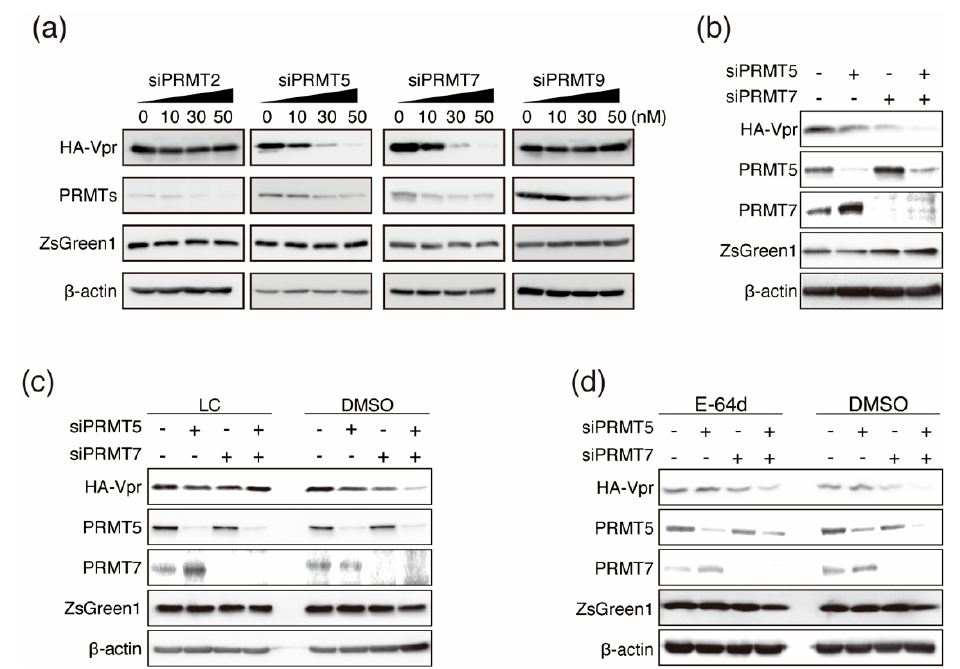
Figure 3. Downregulation of HA-Vpr after siRNA knockdown of PRMTs and rescue by inhibitors. ( a ) HA-Vpr expression using the bicistronic vector HA-Vpr-IRES-ZsGreen1-pCAGGS with siRNA against PRMT2, PRMT5, PRMT7, or PRMT9. Proteins were visualized by immunoblotting at 48 h post-transfection. Lanes marked “0” indicate transfection with siRandom as a negative control. ( b ) HeLa cells were co-transfected with HA-Vpr-IRES-ZsGreen1-pCAGGS together with siPRMT5 (50 nM), siPRMT7 (50 nM), or siRandom (50 nM) as indicated. Lanes marked “ − ” indicate transfection of siRandom. Proteins were visualized by immunoblotting at 48 h post-transfection. HeLa cells were cotransfected with HA-Vpr-IRES-ZsGreen1-pCAGGS and siRNAs against PRMT5 and/or PRMT7, and then treated with 50 µM lactacystin (LC) ( c ) or 50 µM E-64d ( d ) for 6 h starting at 48 h post-transfection. Proteins were visualized by immunoblotting.